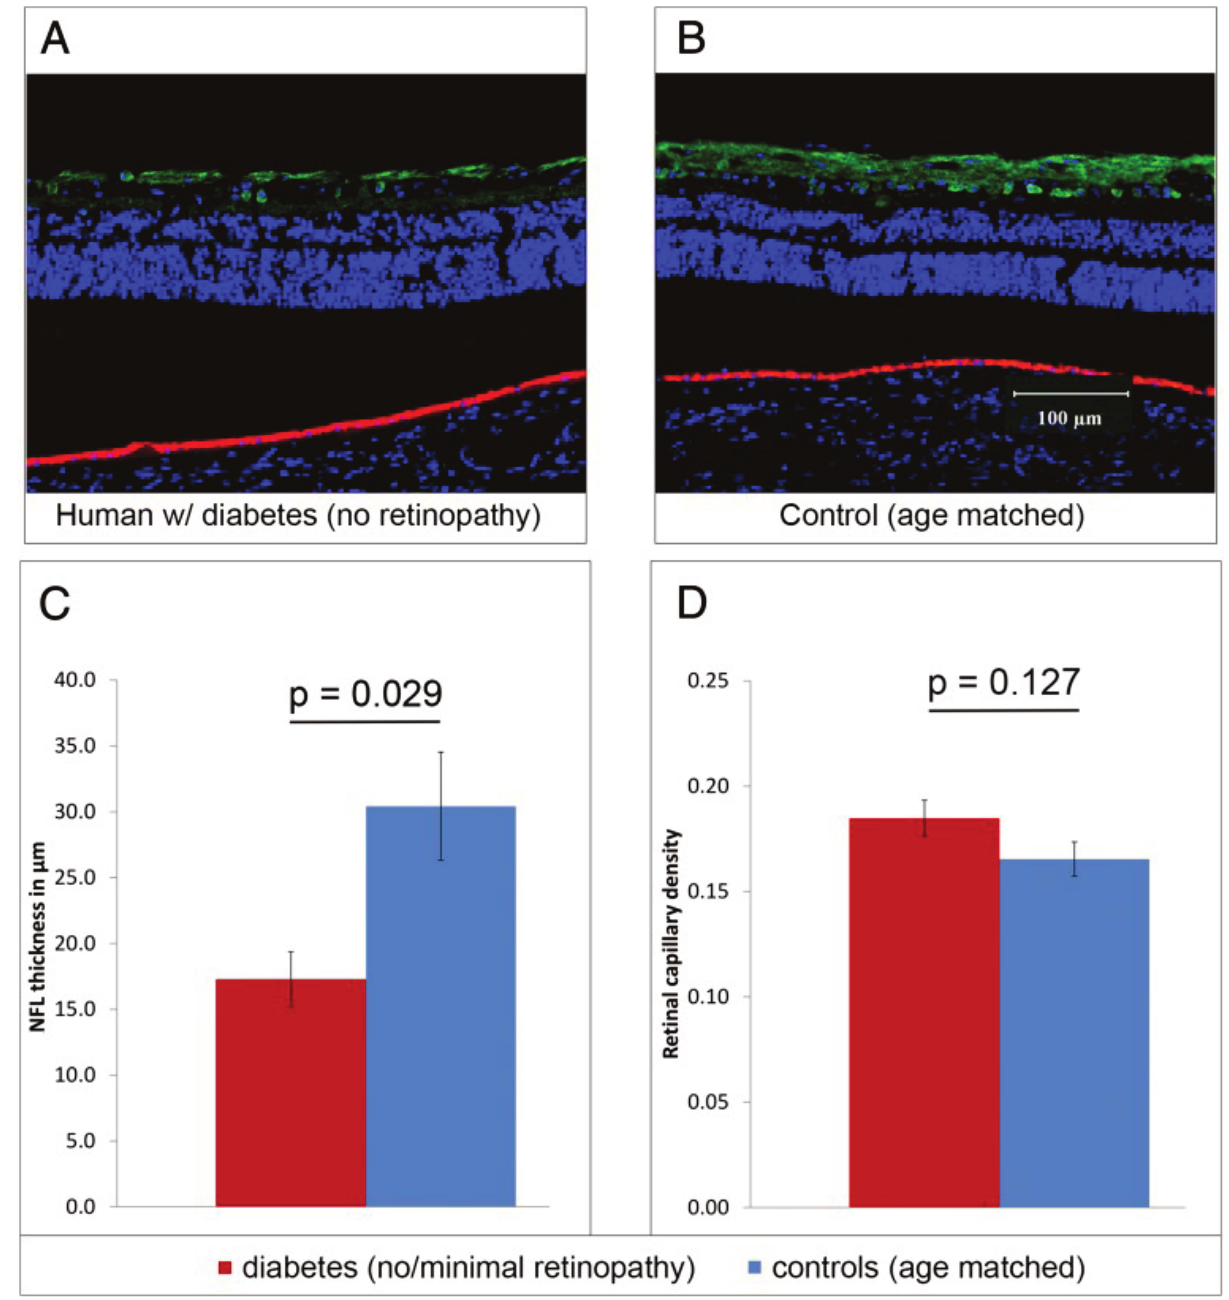
Figure 4: Nerve fiber layer thickness in DM patients with no retinopathy [16]. (A and B) Sections of eye from human donors with DM and no retinopathy (A) and from age-matched controls (B) stained with γ-synuclein antibody to immunolabel GCs and the NFL (green); DAPI nuclear counterstaining is blue; the red-orange signal at the level of the RPE is caused by auto fluorescence. (C) The NFL was significantly thinner in the diabetic eye (n = 6) than in controls (n = 5). (D) Retinal capillary density was measured from whole-mount sections; vessels were immunolabeled with biotinylated UEA-I followed by avidin conjugated to Texas Red (Fig. S4). No significant difference in retinal capillary density was found in the eye from diabetic donors (n = 6) and from controls (n= 5)